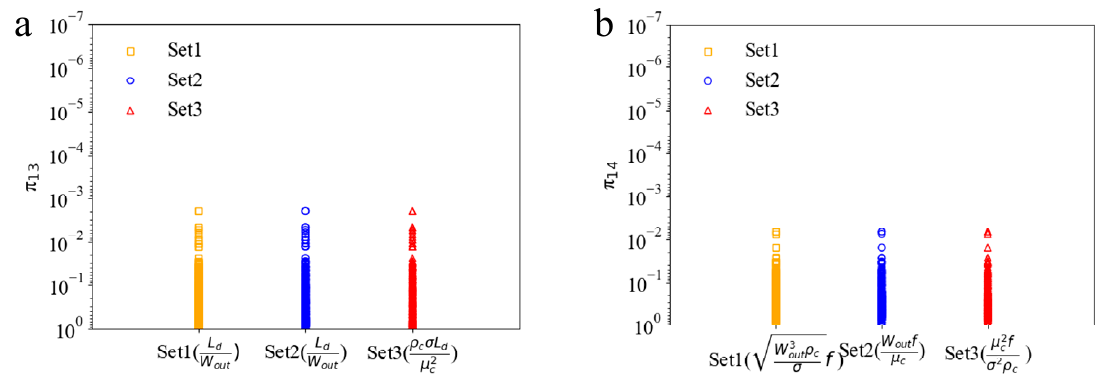
Figure 6. Value ranges of π 13 and π 14 for three sets with slug and dripping patterns in Experiment 2: ( a ) π 13 , ( b ) π 14 . In the slug and dripping patterns of Experiment 1, the order of magnitude of π 13 value changed from 10 − 3 to 10 0 in Set1 and Set2 and from 10 − 4 to 10 0 in Set3. There was one order of magnitude gap of π 13 value between Set1, Set2, and Set3 (Figure 5a). Similarly, the order of magnitude of π 14 value changed from 10 − 3 to 10 0 in Set1 and Set2 and from 10 − 7 to 10 0 in Set3. There was a four order of magnitude gap of π 14 value between Set1, Set2, and Set3 (Figure 5b). It demonstrated that the dimensionless numbers of π 13 and π 14 in Set3 had a widely separate distribution than those in Set1 and Set2, which led to the accuracy decline for the prediction